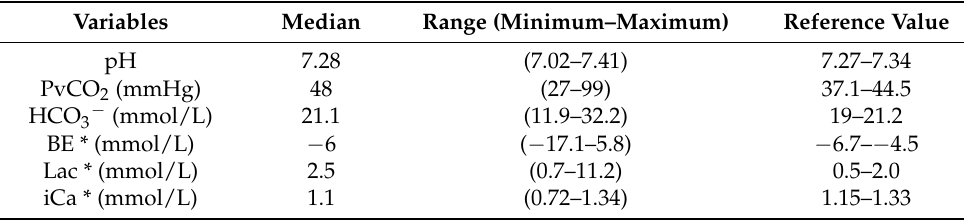
Table 1. Blood gas analysis of cats diagnosed with cardiogenic pulmonary edema.